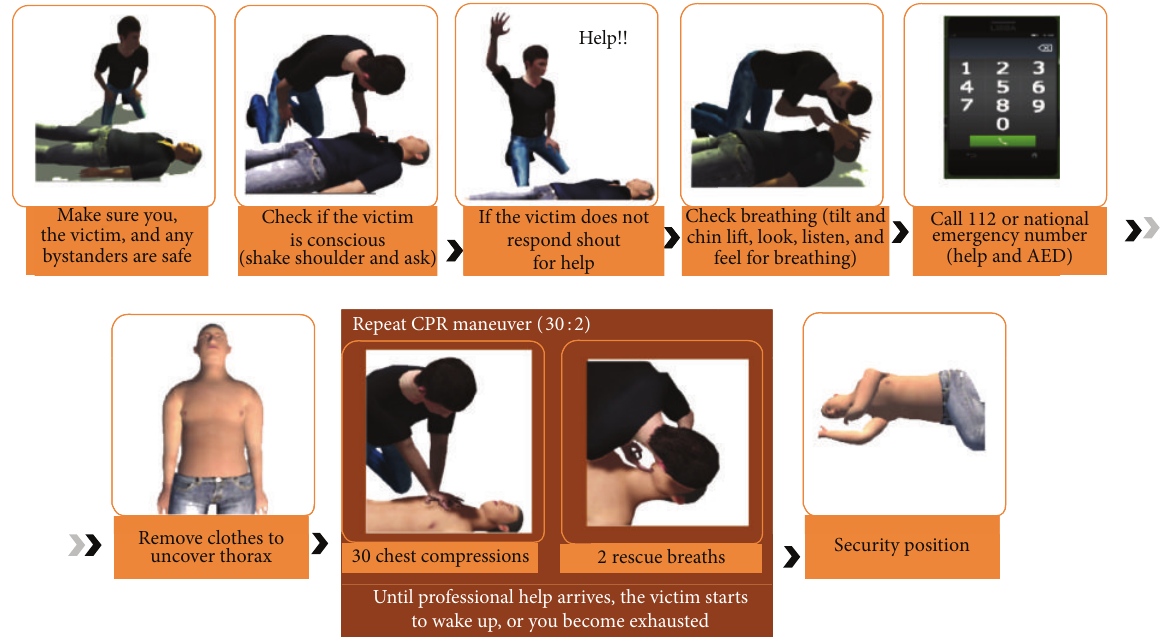
Figure 2: The steps of the basic life support protocol that have been selected to define the proposed game. We will create one mini game per selected